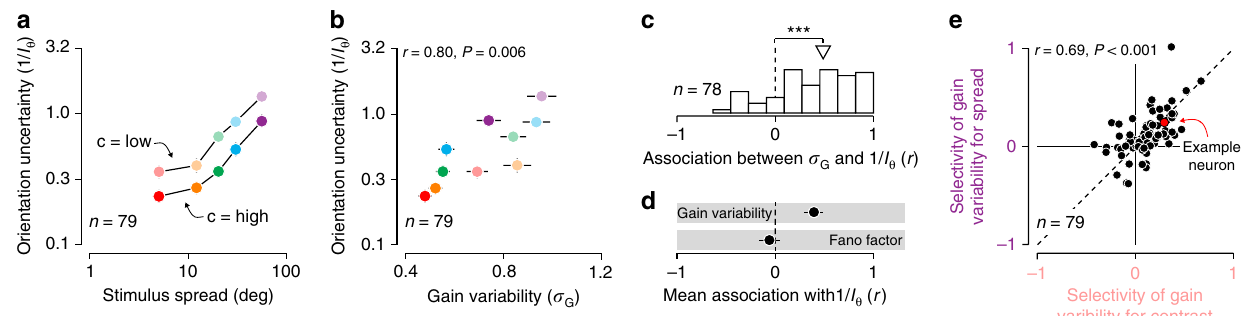
Fig. 3 Gain variability represents stimulus uncertainty. a Orientation uncertainty as a function of stimulus contrast and spread, averaged across a population of V1 and V2 neurons. b Orientation uncertainty as a function of gain variability, averaged across a population of V1 and V2 neurons ( r = 0.80, P = 0.006). c Distribution of the correlation between gain variability and orientation uncertainty for individual neurons. The triangle indicates the median value. d Average correlation between orientation uncertainty and two measures of neuronal response variability. Here, error bars indicate 95 percent con fi dence intervals. e Selectivity of gain variability for stimulus spread as a function of selectivity of gain variability for stimulus contrast (see Online Methods). Error bars indicate ± 1 s.e.m; *** P <